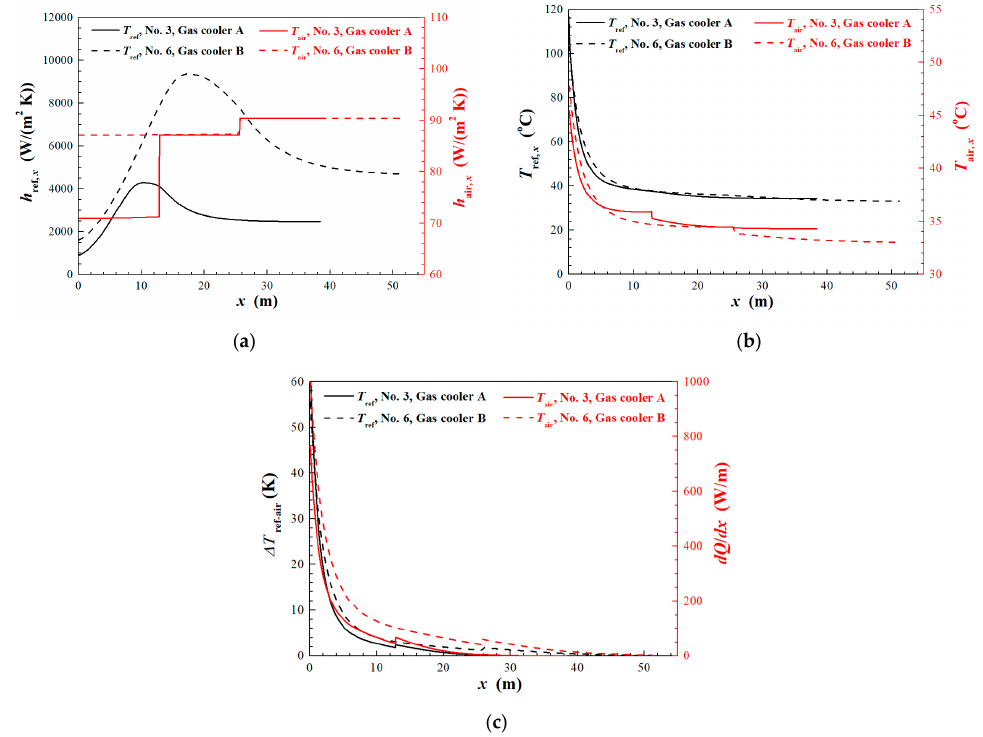
Figure 6. Local heat-transfer performance of sCO 2 and air: ( a ) heat-transfer coefficient; ( b ) temperature and ( c ) temperature difference and heat-transfer gradient.